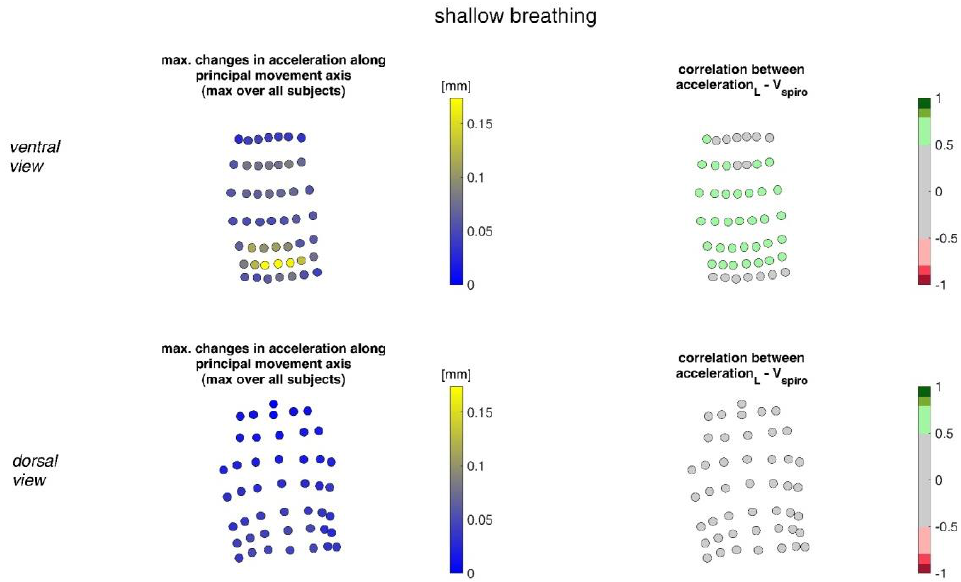
Figure 11. The maximal accelerations of MoCap markers along their main movement axis during shallow breathing (mean over all subjects (left)) and the mean corresponding correlation of these changes with spirometer volume V spiro of all subjects during shallow breathing are shown (right). (Top - ventral view, bottom - dorsal view).